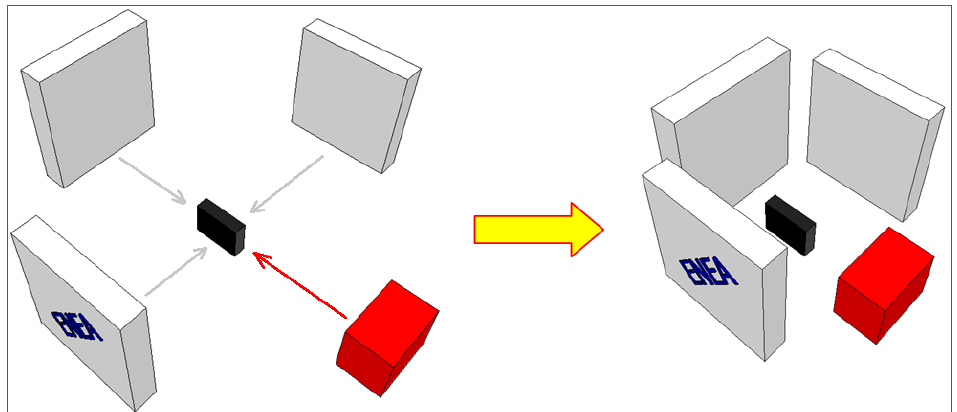
Figure 4. The NAI device experimental setup on the field.